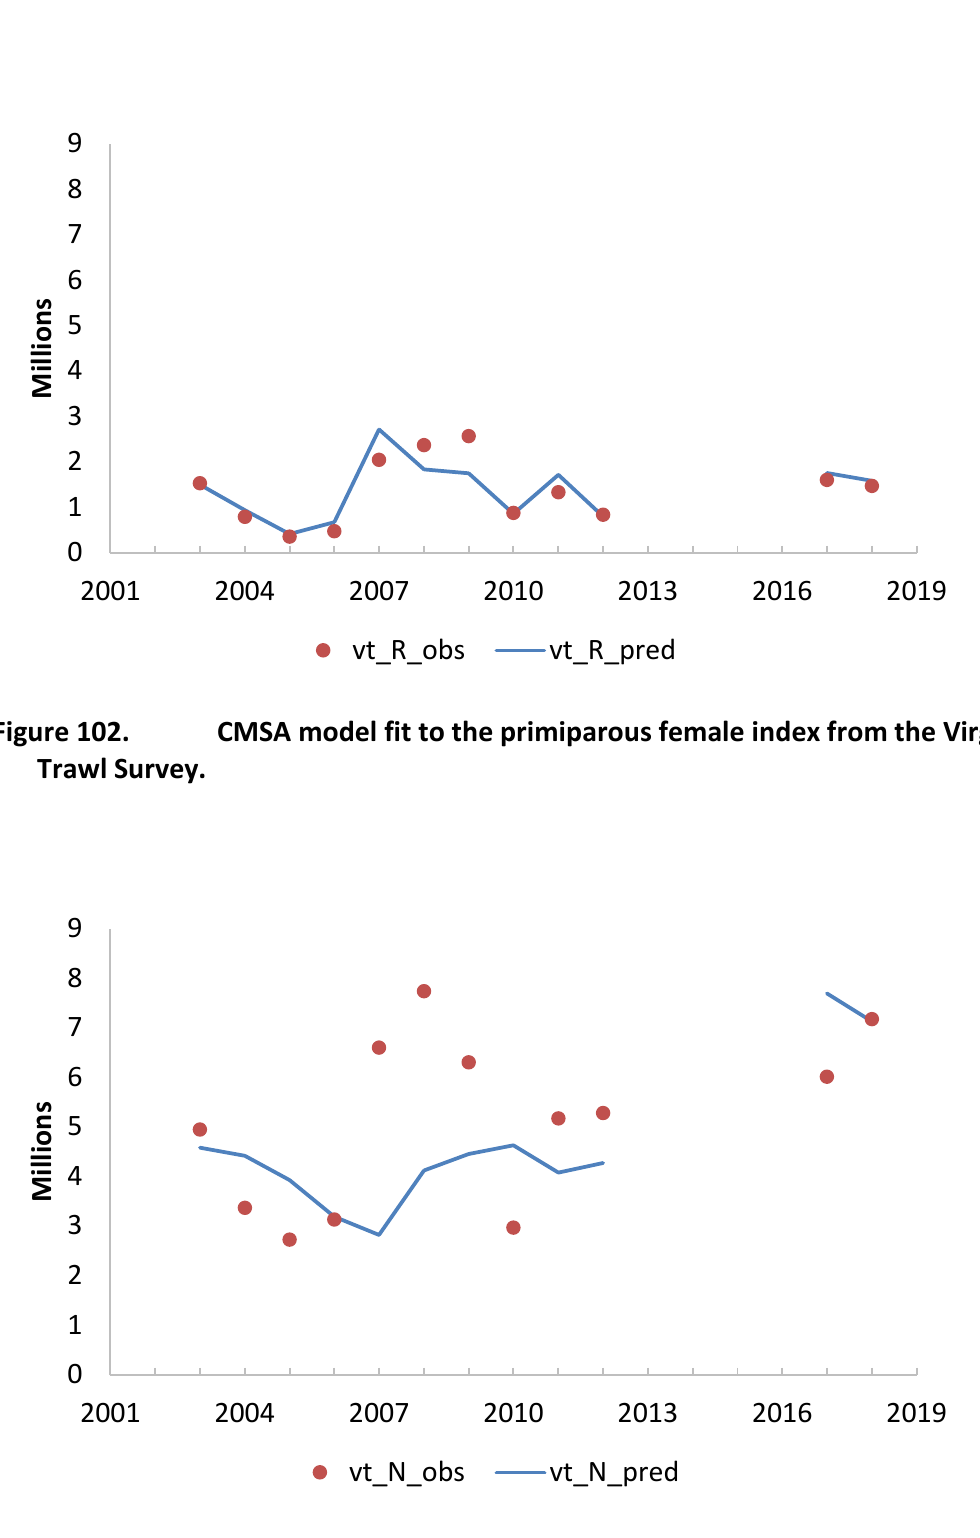
Figure 103. CMSA model fit to multiparous female index from the Virginia Tech Trawl